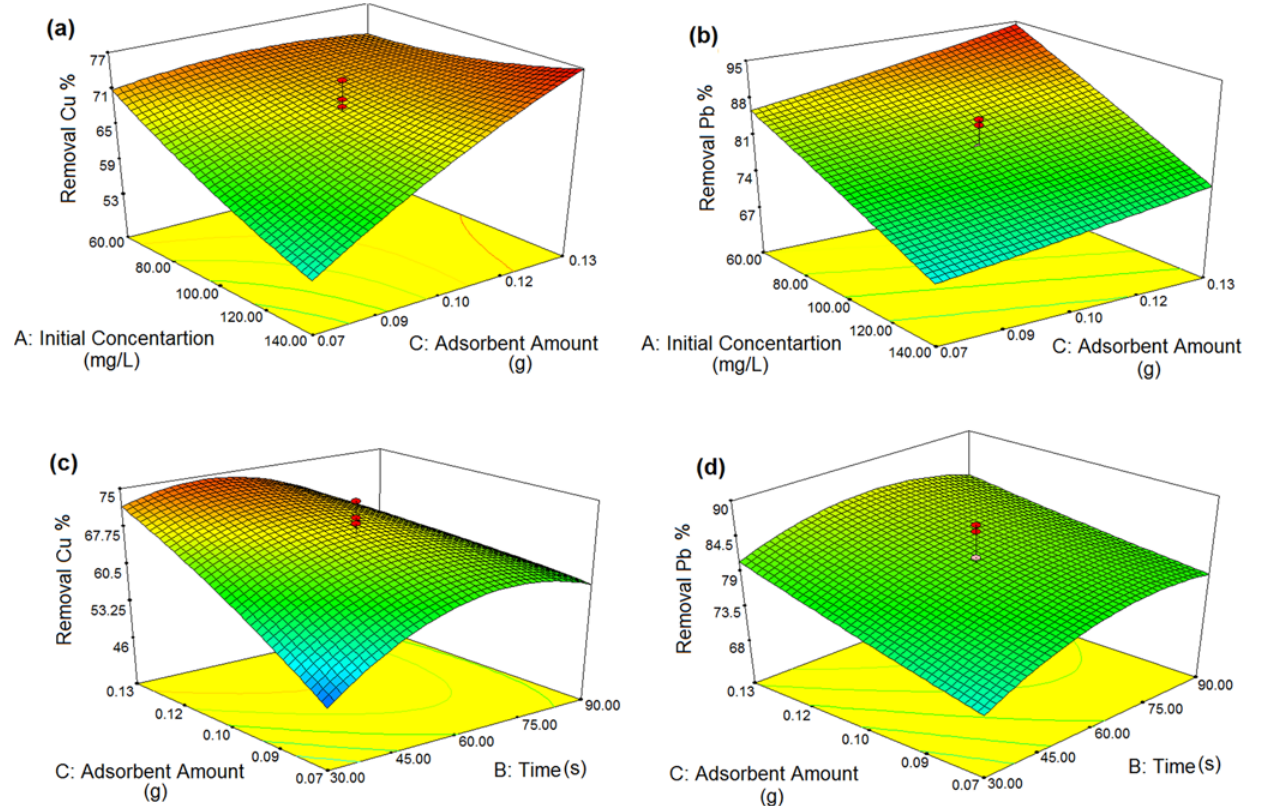
Fig 4. Response surface, showing the effect of initial ion concentration, removal time, and adsorbent dosage on the Cu(II) and Pb(II) percentage Fig. 3 summarizes correlation between experimental and predicted values using the devel- oped model. Fig. 3a and b exhibit the actual values versus predicted values of the product, which indicated a good agreement between actual and predicted response.